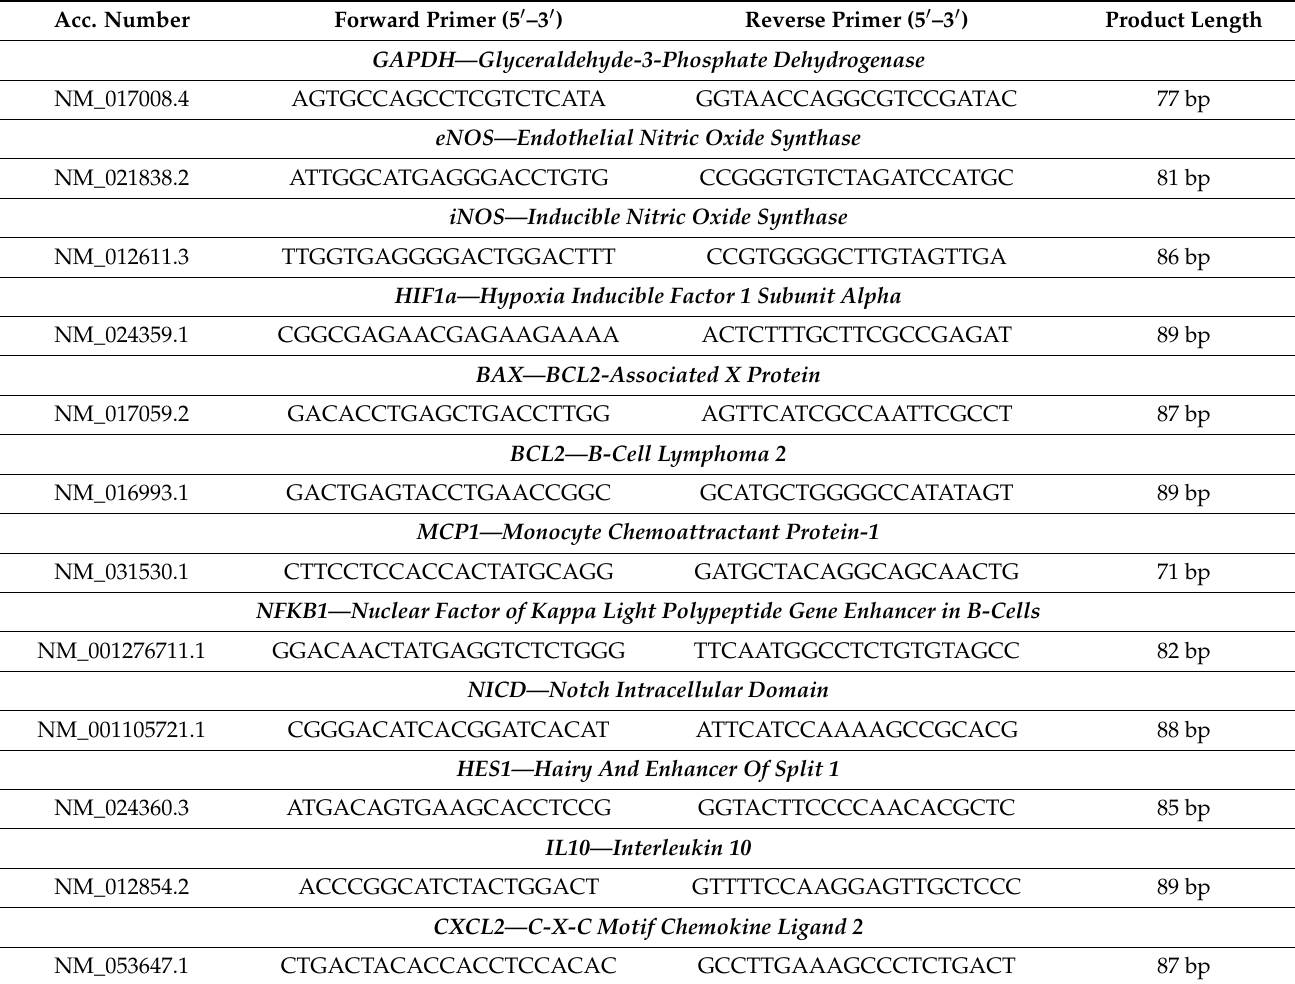
Table 2. Genes used for quantification and primer